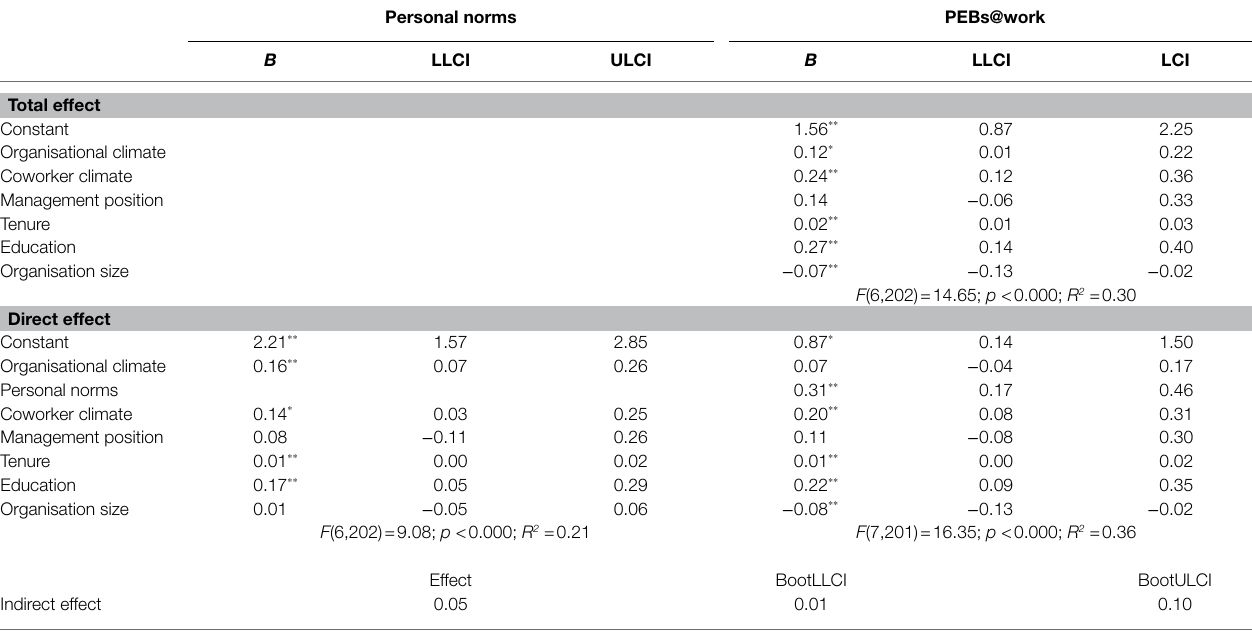
TABLE 2 | Total, direct, and indirect effects. Personal norms